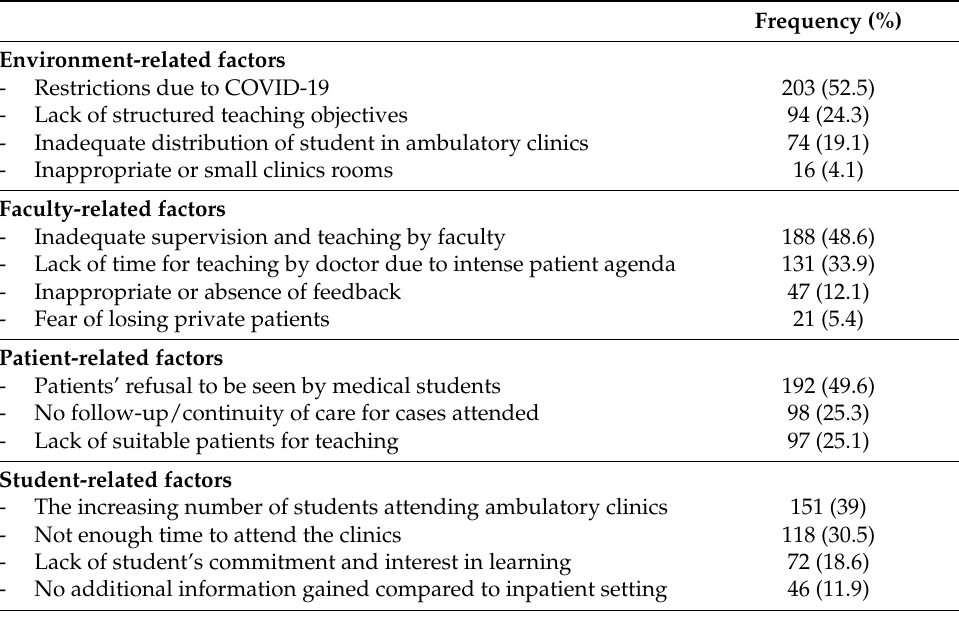
Table 3. Factors considered by medical students as barriers for ACC